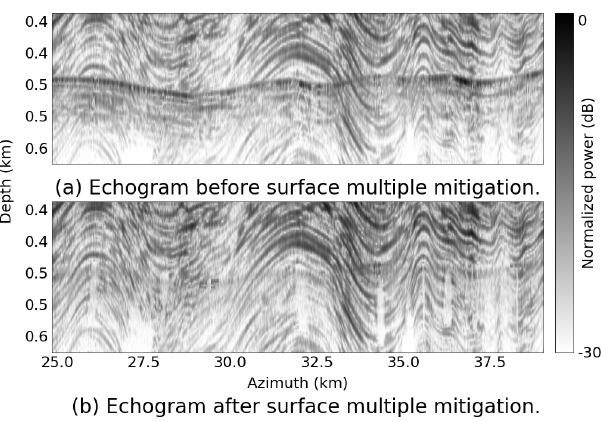
Figure 10. Mitigation of the surface multiple for track 2. The sub- sets of the SAR echogram before and after the mitigation are shown at the top and the bottom correspondingly.